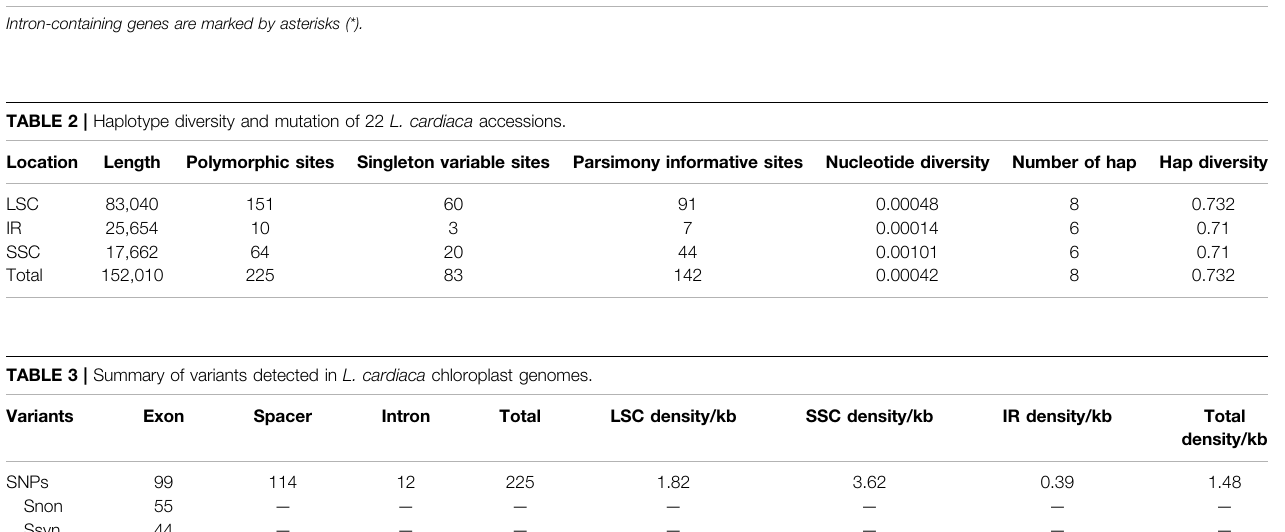
Table S1 ). The nucleotide diversity ranged from 0.00014 (IR region) to 0.00101 (SSC region) among the three different parts, and the overall nucleotide diversity was 0.00042. In the total 225 SNP mutations, 114 mutations were found in intergenic spacers with 99 located in exons and only 12 located in intron regions.